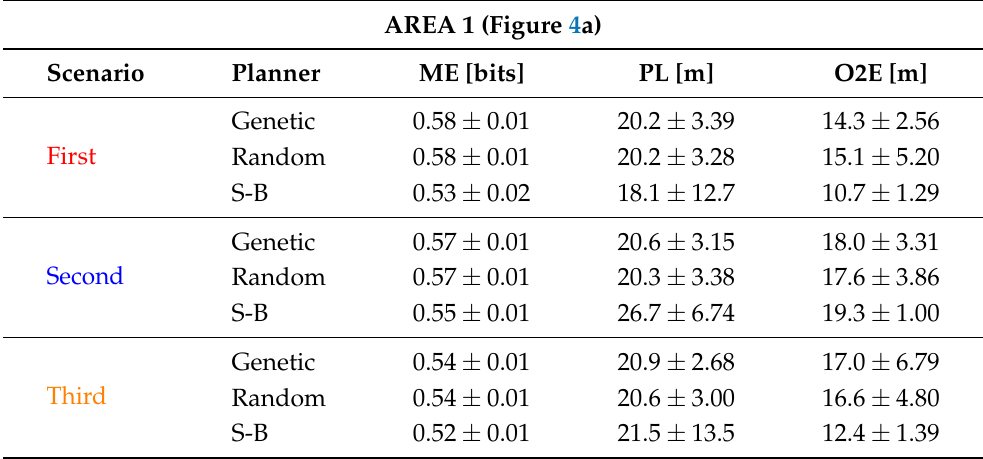
Table 2. Results, in terms of mean and three times the std. dev., of the 3 planners in 3 scenarios of Area 1.